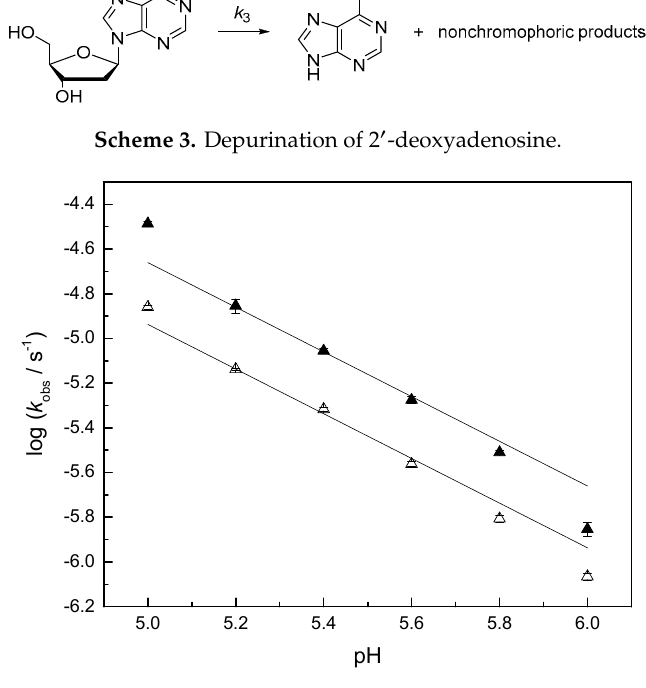
Figure 3. pH – rate profiles for the depurination ( k 3 ) of 2 ′ -deoxyadenosine in the absence (open triangles) and presence (filled triangles) of Hg(II); T = 90 °C; [Hg(II)] = 0/5 mM; [buffer] = 30 mM; I (NaNO 3 ) = 100 mM.